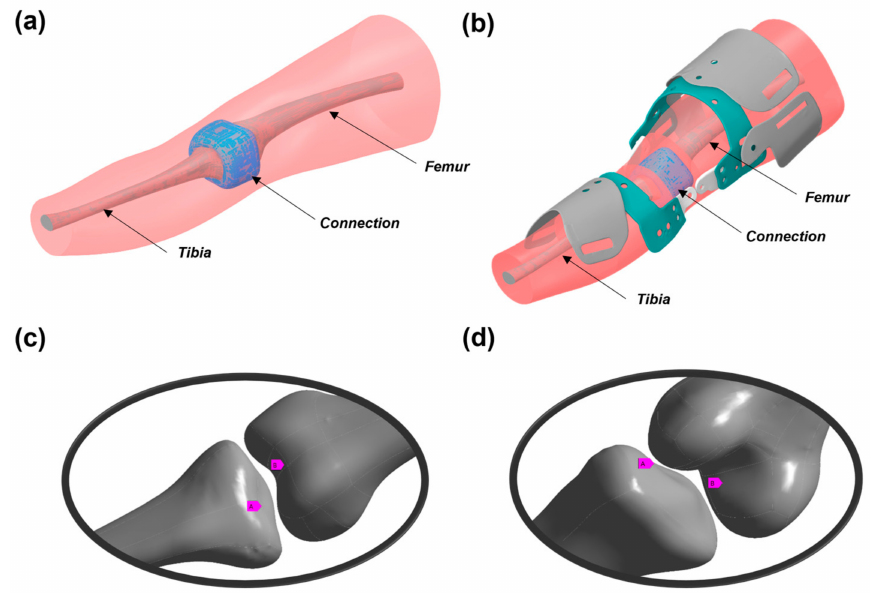
Figure 5. ( a ) FE model without bracket, ( b ) FE model with all the components of the bracket, ( c ) anterior view of the knee joint, ( d ) posterior view of the knee joint. A represents the bone insertion of the ACL on the Tibia and B represents the other bone insertion on the